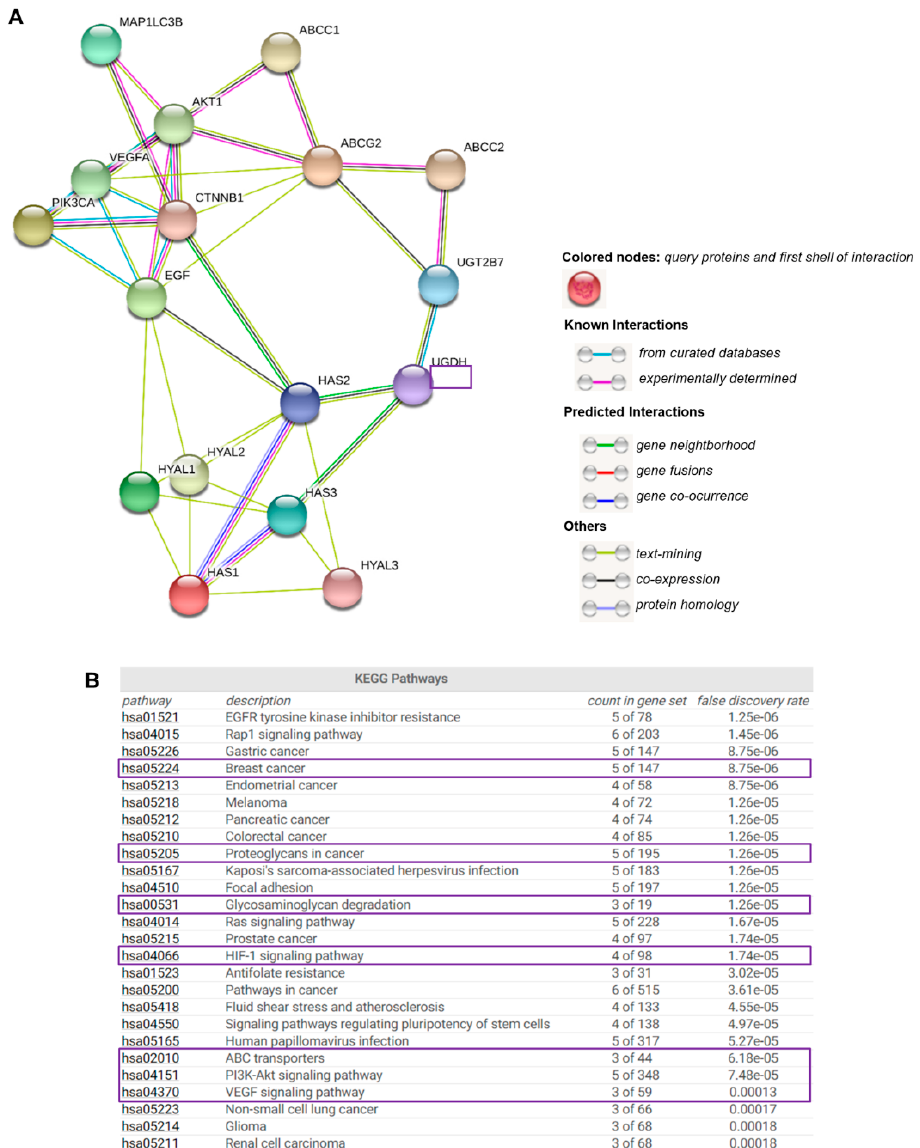
Figure 8. The complex network of genes involved in drug resistance, hyaluronan metabolism and angiogenesis. STRING database output depicting functional and physical interactors of UGDH, UGT2B7, HAS1, HAS2, HAS3, HYAL1, HYAL2, HYAL3, PI3K (PIK3CA), AKT1, b-CATENIN (CTNNB1), VEGF, EGF, LC3-II (MAP1LC3B), ABCC1, ABCC2 and ABCG2 obtained from http://string-db.org/( A ). KEGG pathway analysis ( B ).